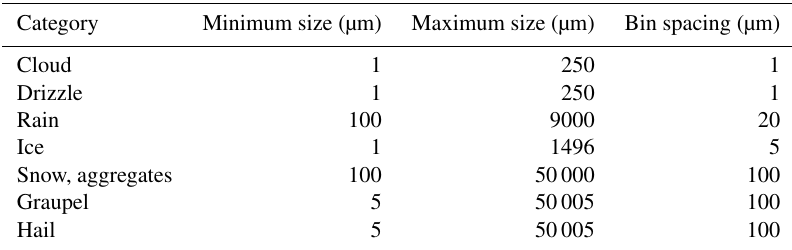
Table 1. The minimum and maximum sizes and bin spacing of simulated particles for each hydrometeor category from the bulk microphysics schemes except the P3 scheme. “Particle size” here refers to the maximum particle dimension.